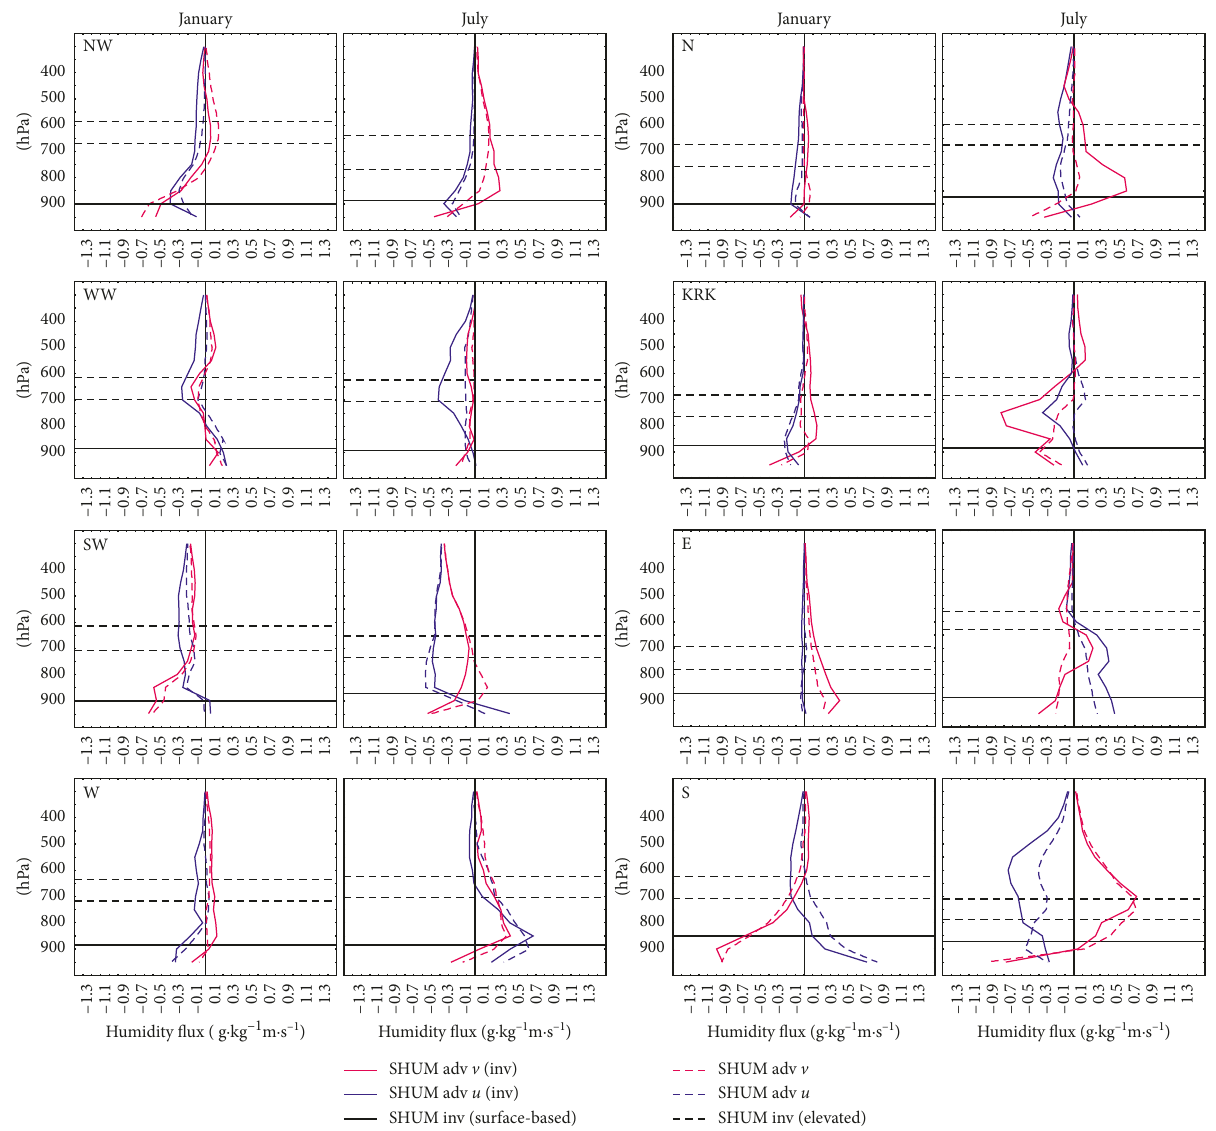
Figure 10: Climatologic mean profiles of specific humidity advective flux: eastward ( u ) and northward ( v ) during inversion (solid curve) and noninversion (dashed curve) events (detailed description in the text) at selected grid points (for details, see Figure 1 and Table